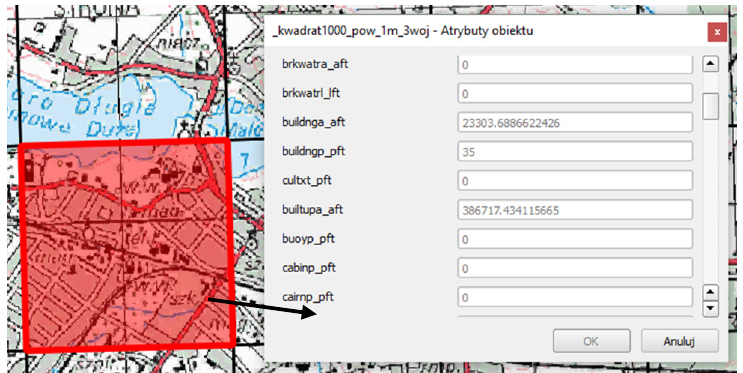
Figure 1. An example of selected parameters for a cell.